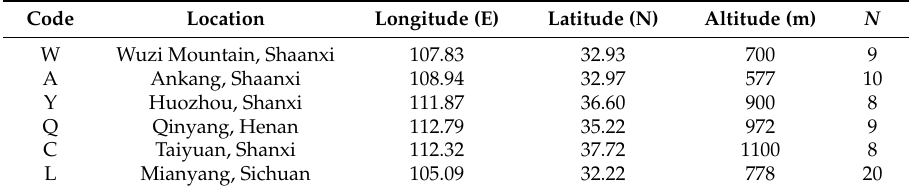
Table 1. Information on the geographical distribution of wild populations of Pinus bungeana . Code Location Longitude (E) Latitude (N)